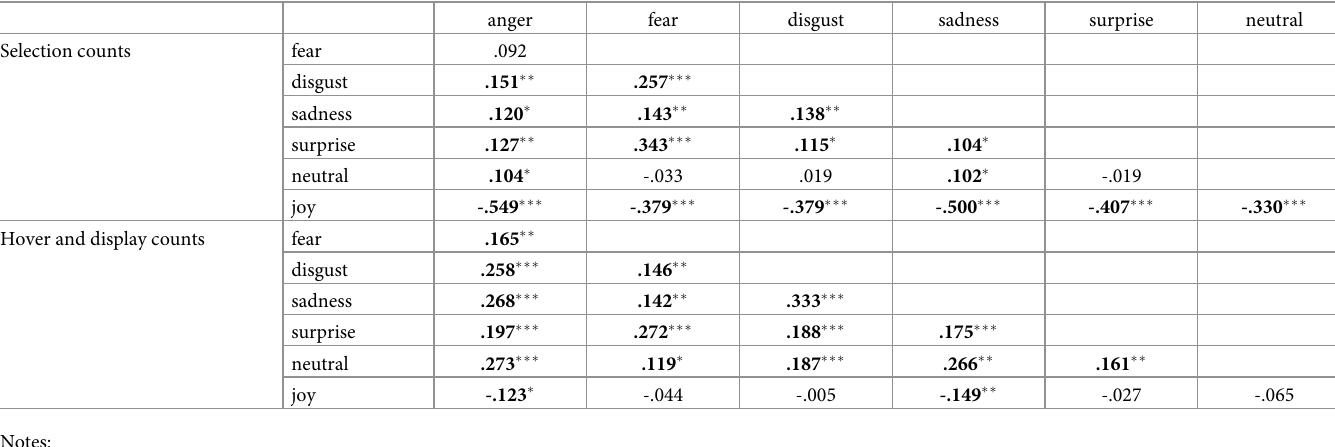
Table 3. Intercorrelations between EBA-SPT basic emotions (selection and HD counts)—Results of Spearman’s rank order correlation